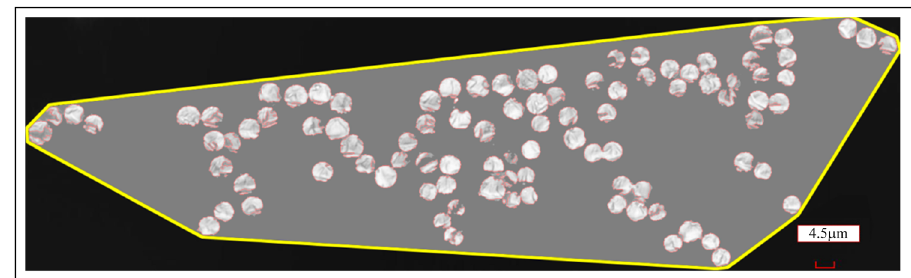
Figure 9: Evaluation of clustering property of C1200 glass yarn.